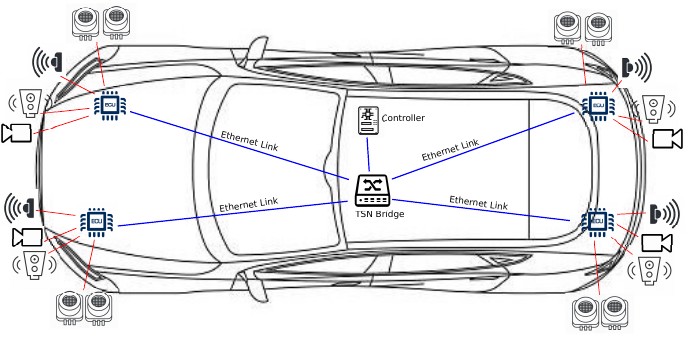
Figure 3. Simulated